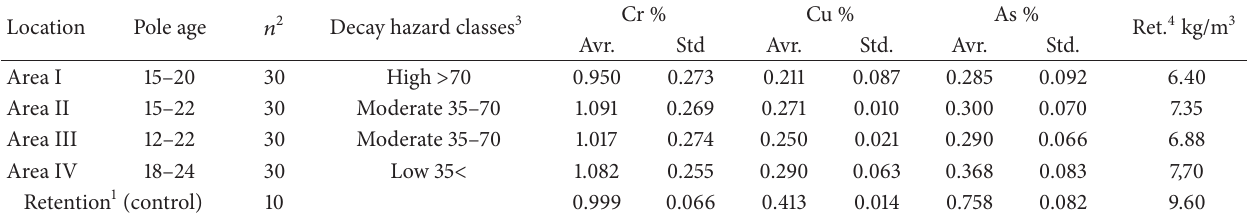
Table 3: Cu, Cr, and As amounts in utility poles inspected in 4 study